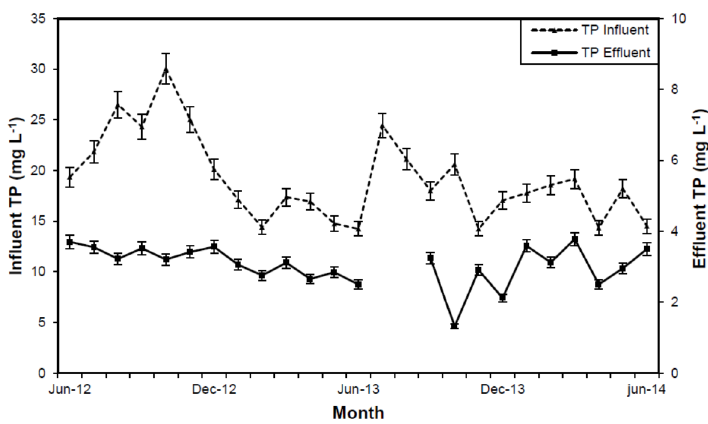
Figure 5. Total phosphorous (TP) concentrations at the influent and the effluent of the studied horizontal subsurface flow constructed wetland.